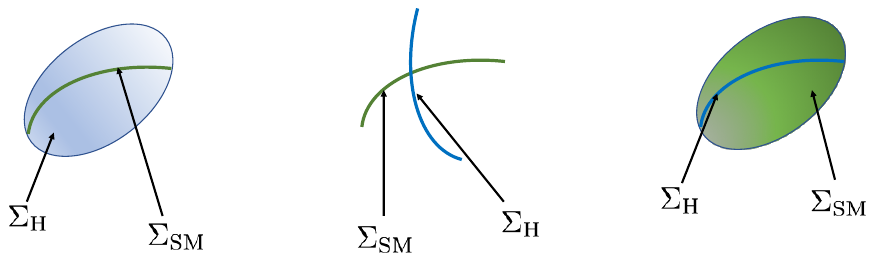
Figure 1 . Three possible situations involving intersection between the locus in moduli space (cid:6) H where the hidden sector bundle stabilizes the complex structure and the locus (cid:6) SM where the spectrum of the standard model bundle jumps. The only case in which the moduli stabilization mechanism forces the standard model spectrum to change is the last, as discussed further in the